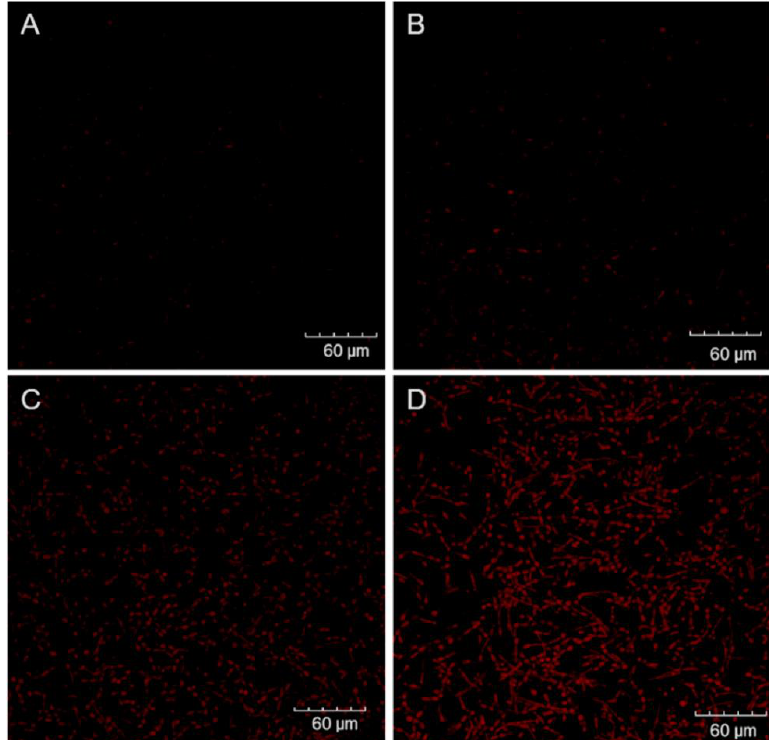
Figure 3. Representative confocal microscopy images of C. albicans ATCC 90028 biofilms grown for 48 h and stained with PI after treatments. Control ( A ): biofilm without irradiation; dark ( B ): biofilm incubated with 1.5 µM of ZnP hexyl without irradiation; light ( C ): biofilm irradiated only (4.3 J/cm 2 ); aPDI ( D ): biofilm incubated with 0.8 µM of ZnP hexyl for 10 min followed by irradiation (4.3 J/cm 2 ).